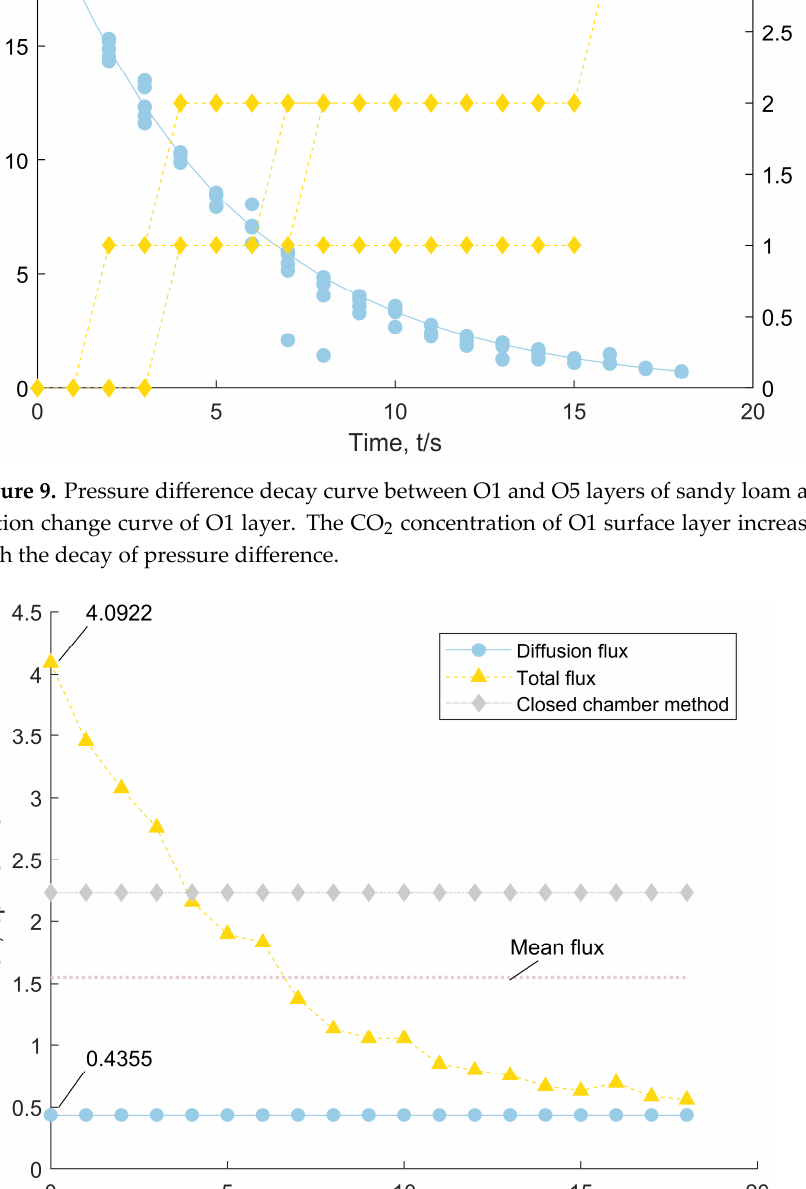
Figure 10. Comparison of the flux calculated using Equation (6) with that calculated flux based on the method of closed chamber using Equation (15) and the calculated flux of pure diffusion using Equation (2).